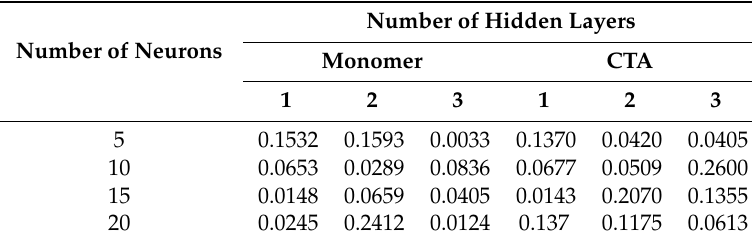
Table 2. Effect of number of hidden layers and number of neurons on MSE.